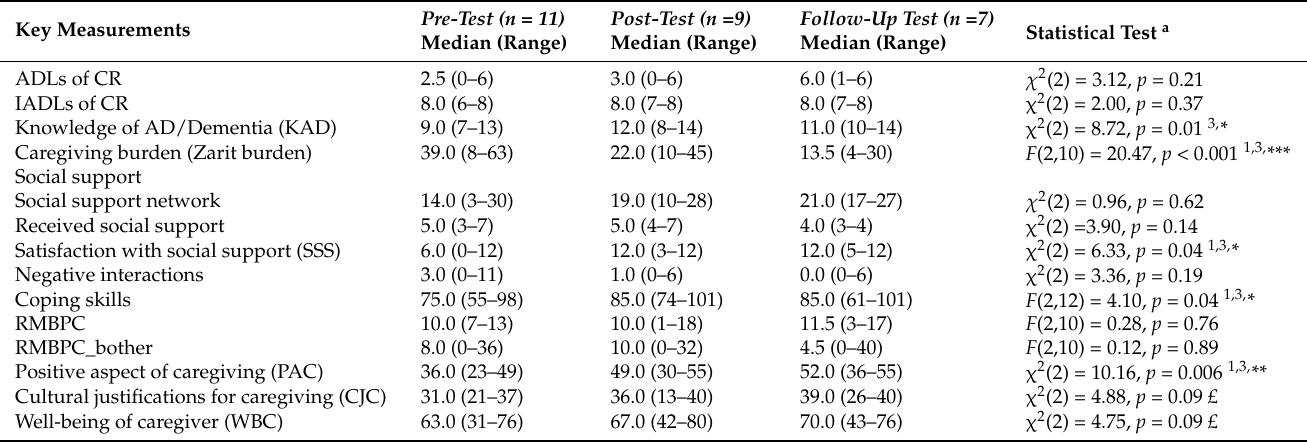
Table 3. Key measurements in pre, post, and follow-up tests for CGs in 2 sites (Texas and Arkansas).